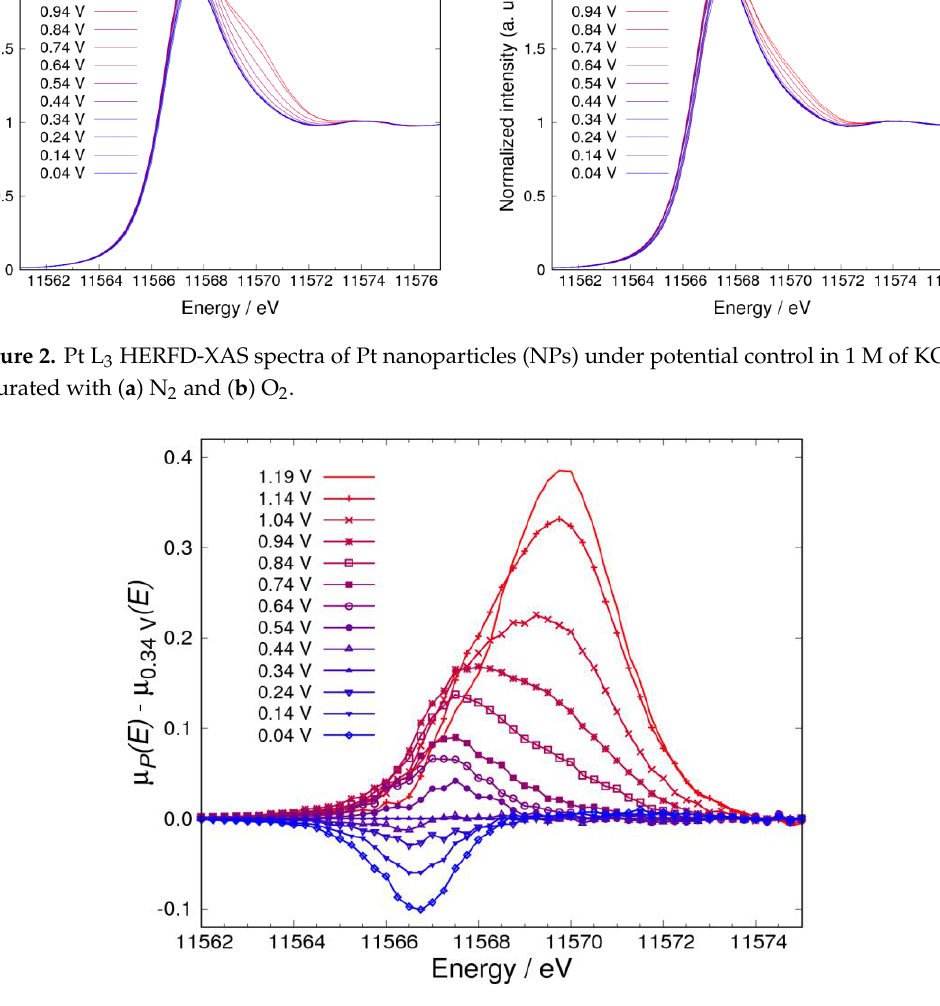
Figure 3. Δ μ XANES spectra for the catalyst calculated by 𝜇 𝑝 (E) − 𝜇 0.34V (E) under potential control in 1 M of KOH saturated with N 2 .